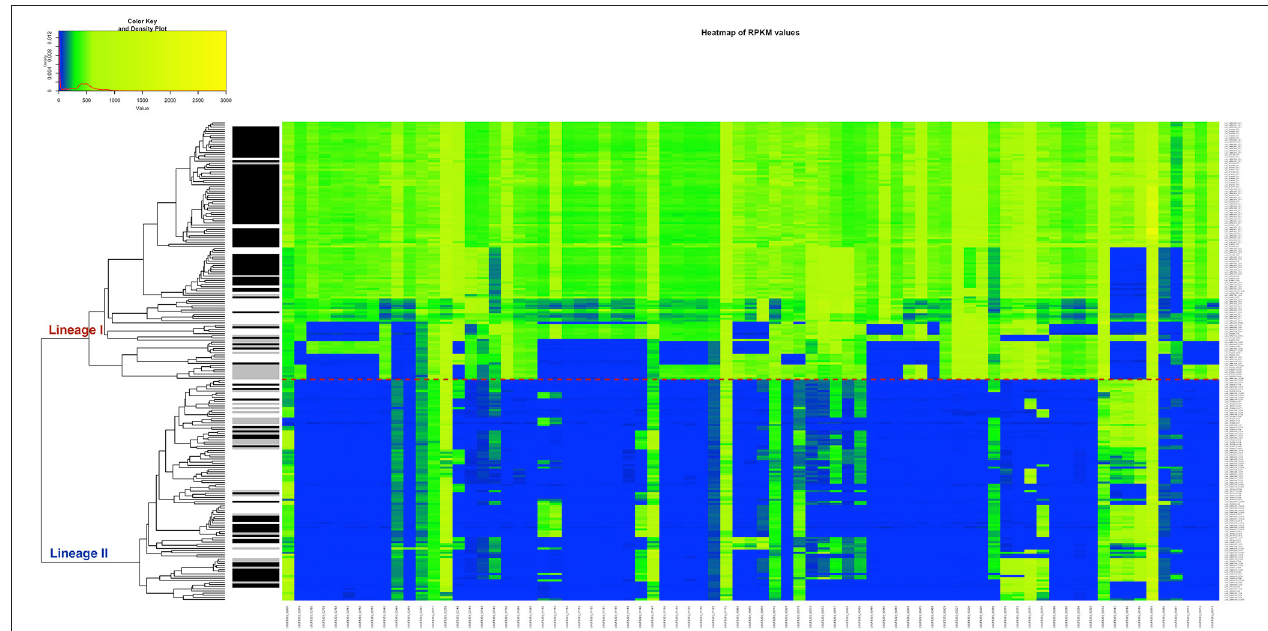
FIGURE 7 | Heatmap of the RPKM values per gene for the 77 selected genes in the 225 sequenced strains after the comparison between the CNS-infection strains and non-CNS infection strains. Red line: separation between the lineages I and II. Gray scale color bar corresponds with the source of infection: black, CNS infection isolates and one septicemia case; gray, other clinical manifestations; white, environmental and two food strains.